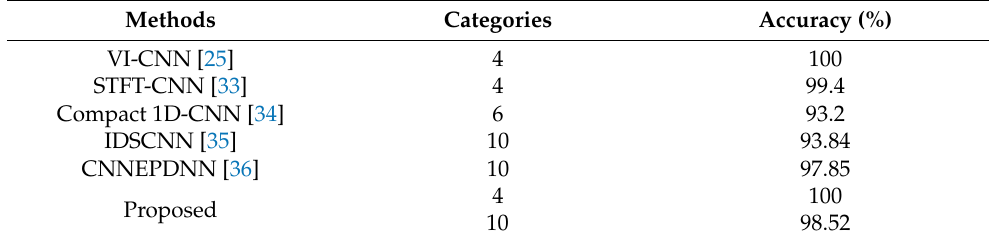
Table 7. Experimental results of different